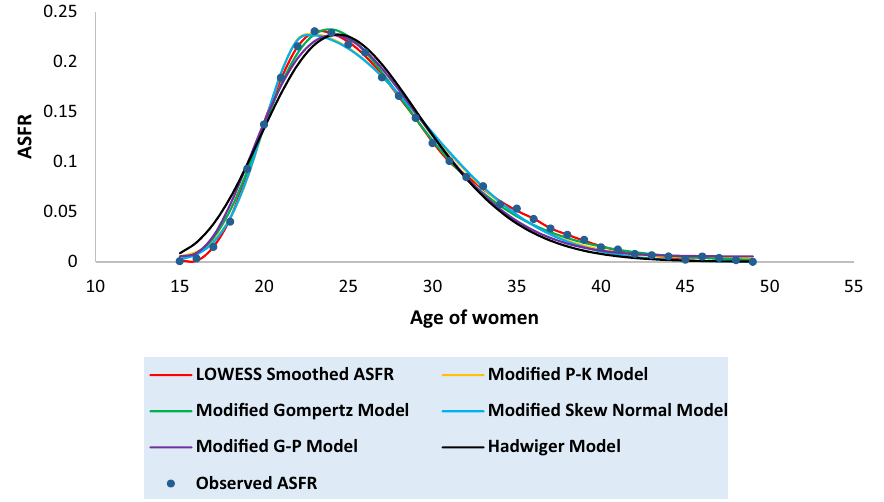
Figure 5. Observed and expected age-specific fertility rate (ASFR) for Uttar Pradesh under different proposed models and Hadwiger model.